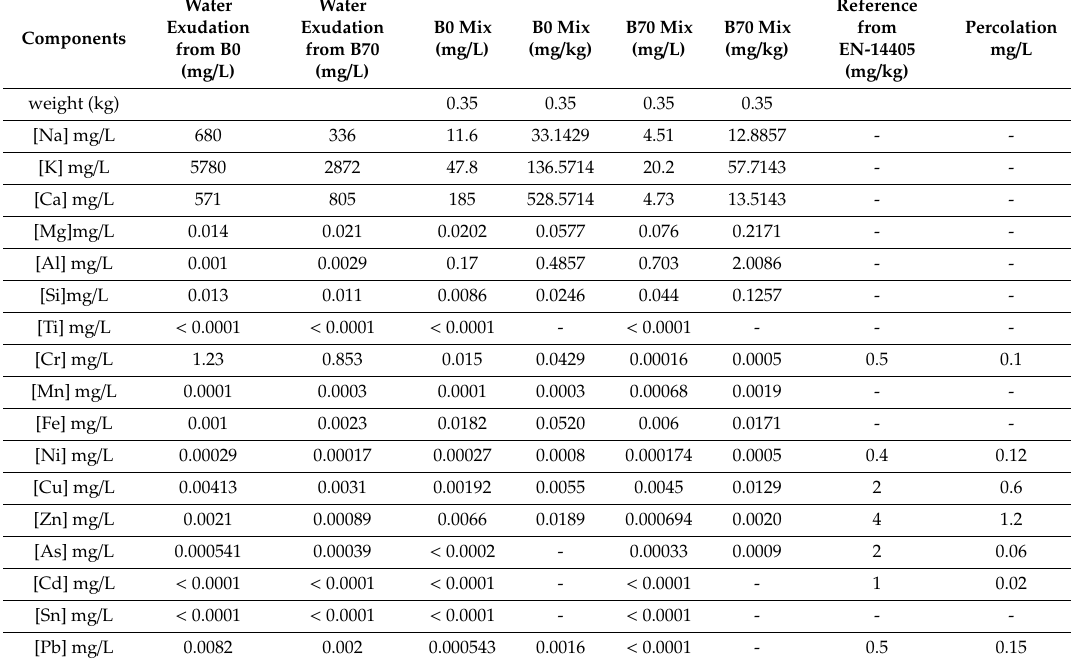
Table 6. Leaching results of B0 and B70